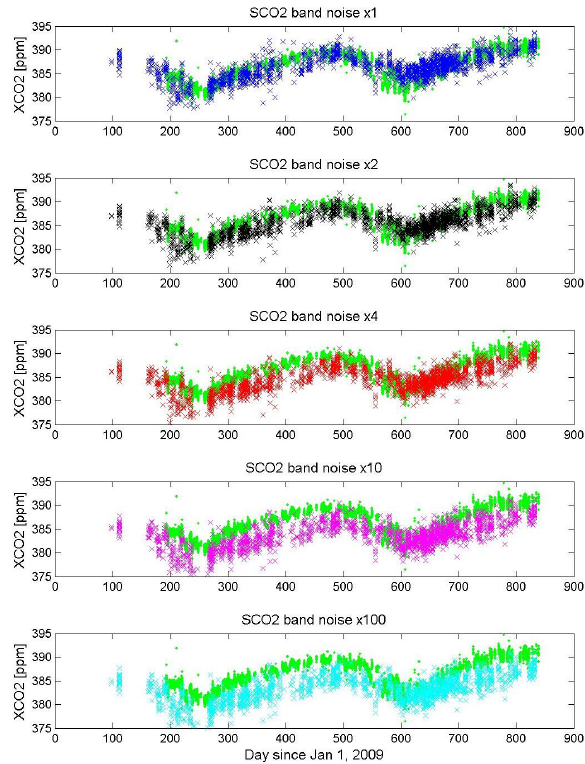
from TCCON (green) and GOSAT 2